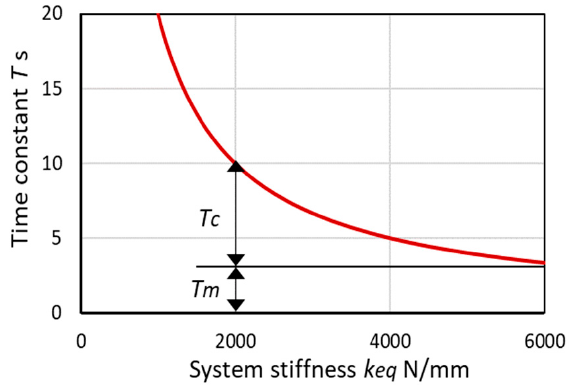
Figure 7. The e ff ect of system sti ff ness on the time Figure 7. The effect of system stiffness on the time constant.